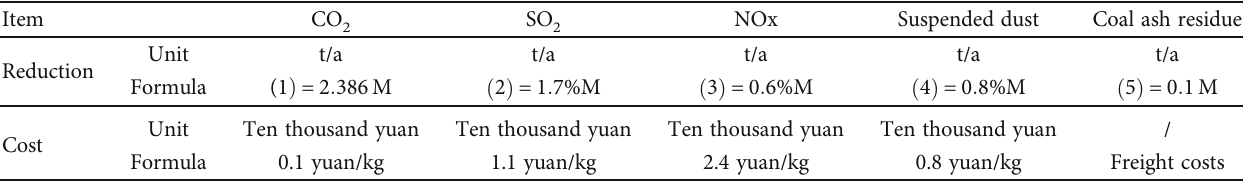
Table 8: Pollutant emission reduction and cost-saving.